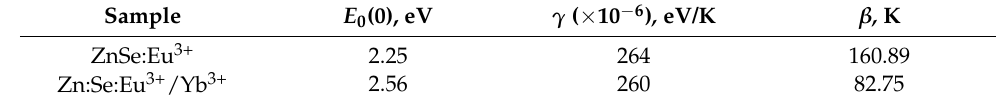
Table 2. Values of the Varshni parameters obtained from the fitting of Equation (2).